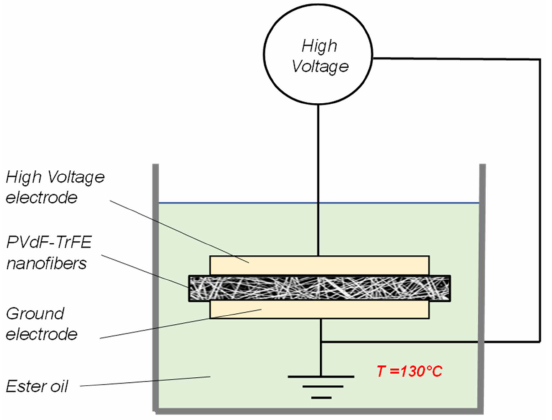
Figure 1. Schematic representation of the polarization